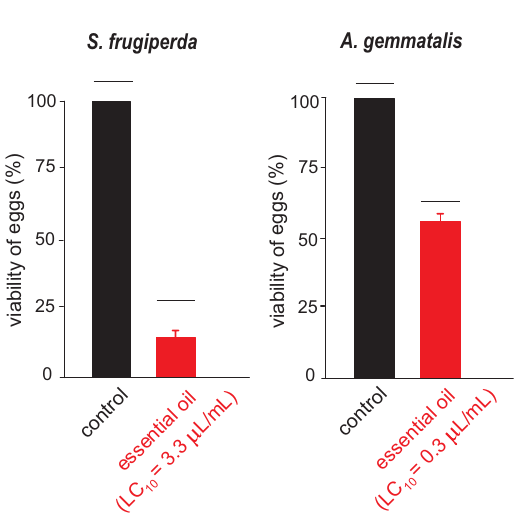
Figure 1. Viability of eggs of Spodoptera frugiperda and Anticarsia gemmatalis unexposed (control) and exposed to sublethal dose (LC 10 ) of the essential oil of Siparuna guianensis . Horizontal bars indicate significant differences ( P < 0.05) between exposed and unexposed eggs.